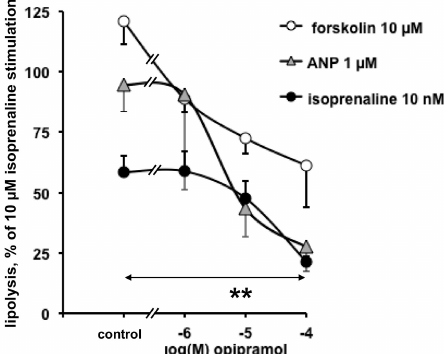
Figure 3. Opipramol exhibited inhibitory e ff ect on various lipolytic agents in human abdominal adipocytes. The lipolytic responses to 10 µ M forskolin, 1 µ M atrial natriuretic peptide (ANP), or 10 nM isoprenaline were expressed as percentage of the maximal glycerol release capacity (which reached 0.9 ± 0.1 µ mol glycerol / 100 mg lipid / 90 min in response to 10 µ M isoprenaline). Each of these responses with lipolytic agent alone (control) was impaired by increasing doses of opipramol (from 1 to 100 µ M). Each point is the mean ± SEM of six di ff erent adipocyte preparations. Di ff erence between 100 µ M opipramol and its corresponding control with each lipolytic agent alone at **: p <